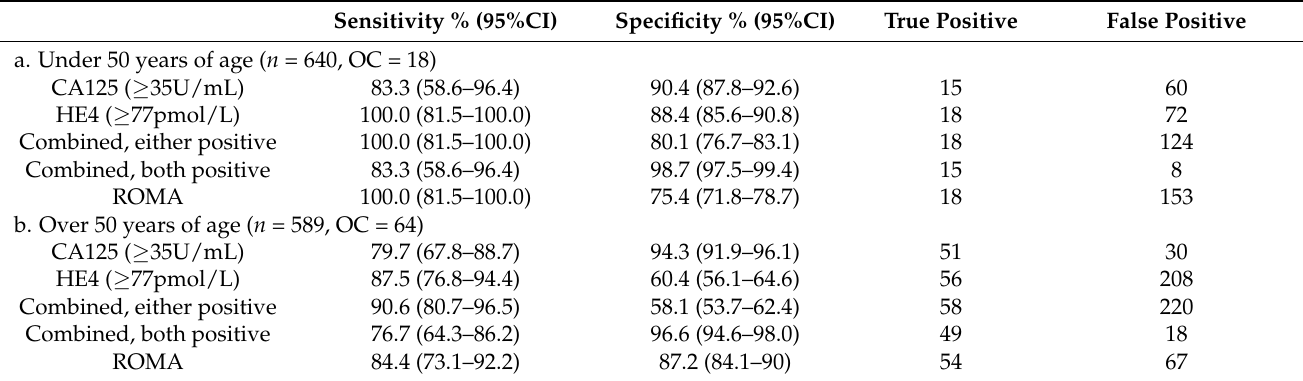
Table 4. Sensitivity and specificity of serum HE4, CA125 (alone and in combination) and ROMA for the detection of ovarian cancer stratified by age under and over 50